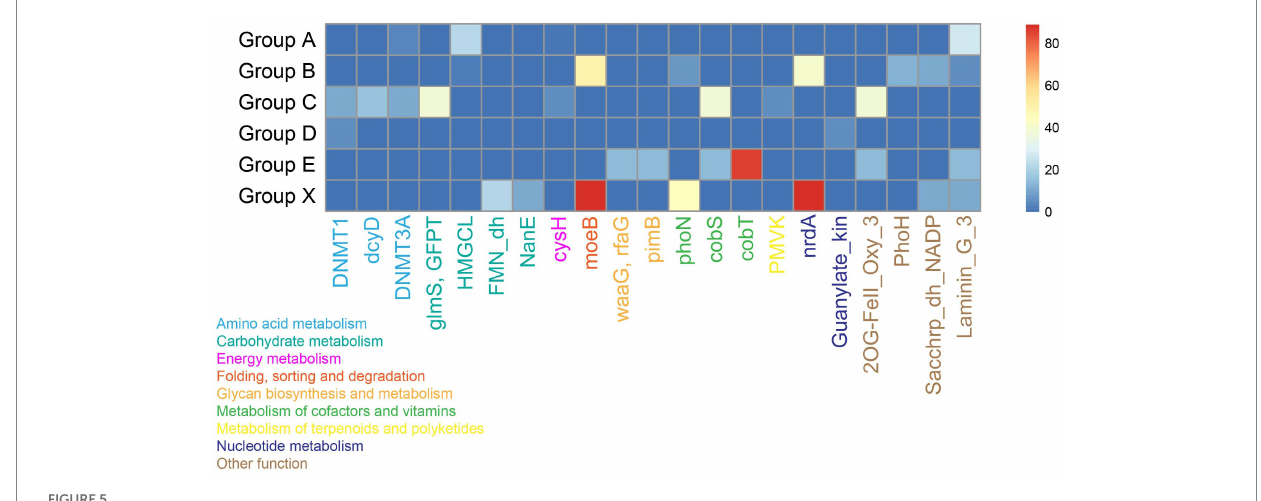
FIGURE 5 Heatmap shows the presence of AMGs in magroviral groups. Color density shows the percentage of magroviral genome encoding the AMG in each